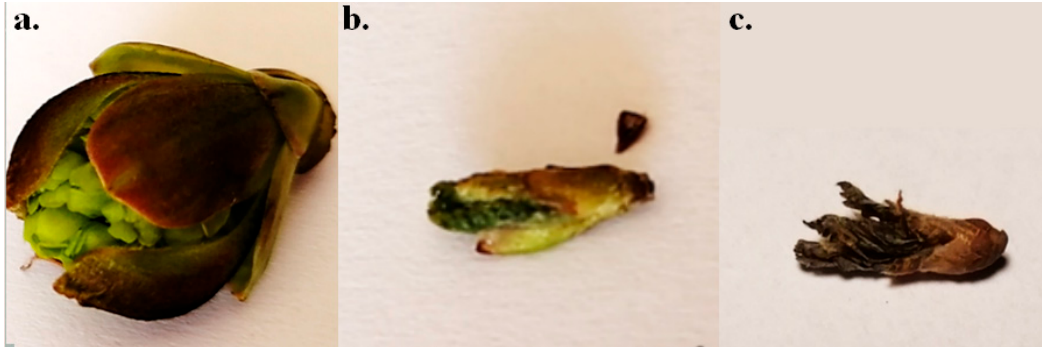
Figure 1. Buds of individual trees collected in April 2020; ( a ). Acer pseudoplatanus , ( b ). Betula pendula , ( c ). Quercus robur.